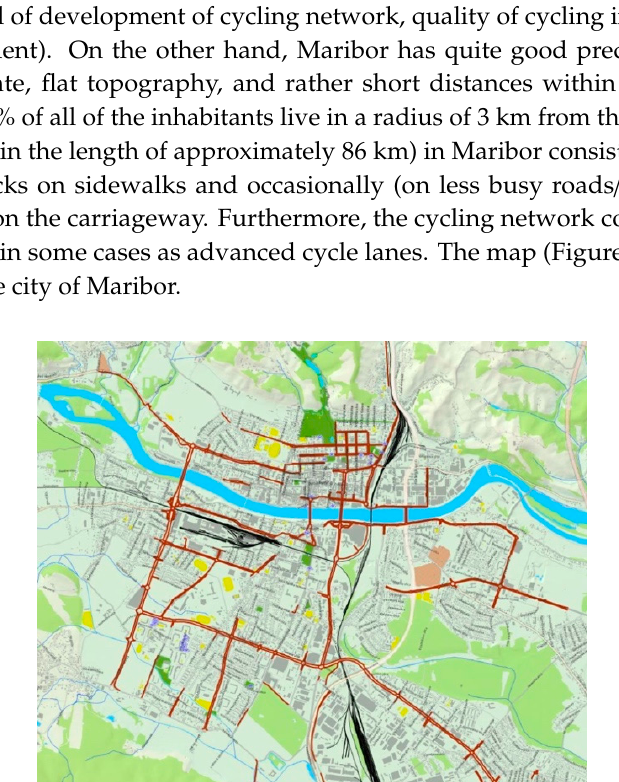
Figure 4. Cycling network in Maribor [4].